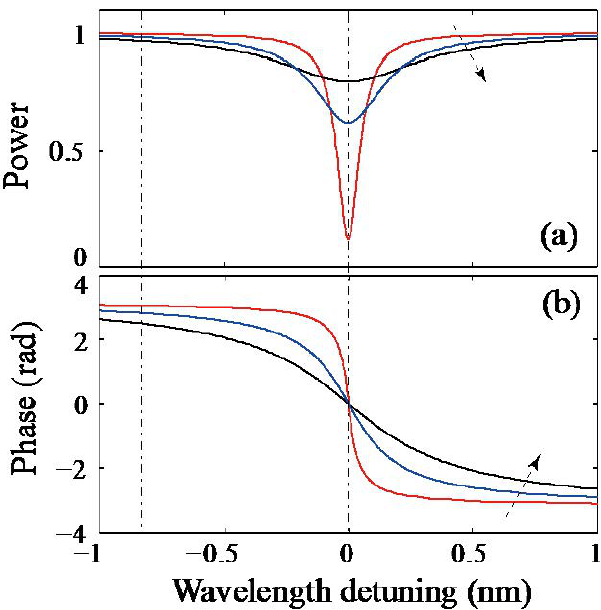
Figure 2: (a) Power and (b) phase responses of an all-pass ring res- onantor under the overcoupled condition. For the different curves shown here, the coupling coeflcients between the ring and the bus waveguide increase along the direction of the dashed